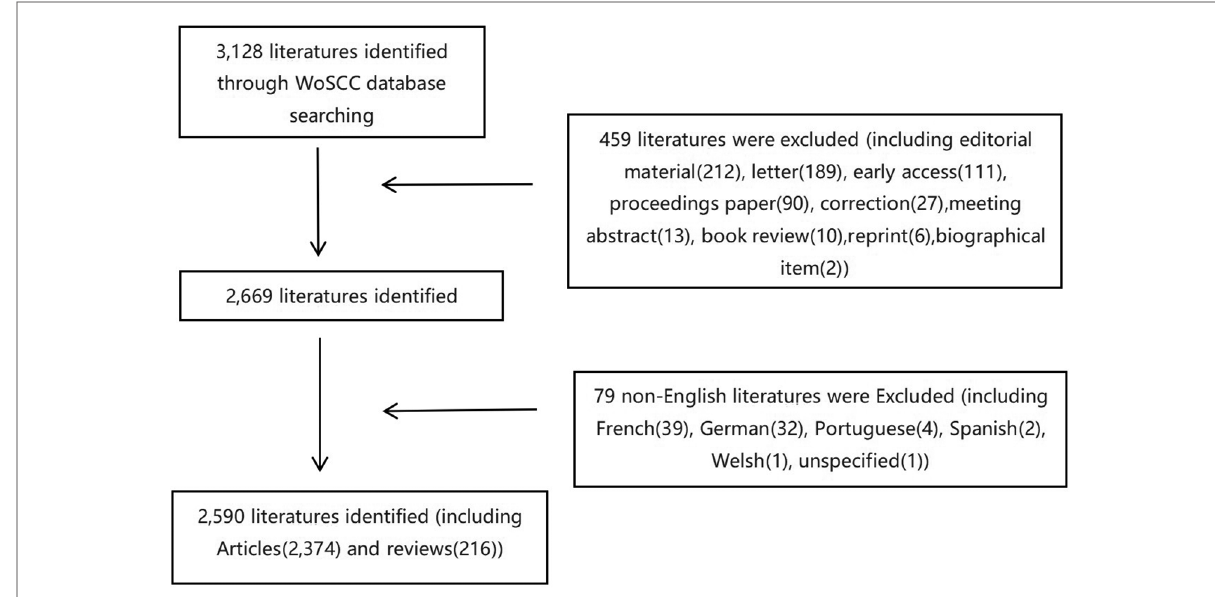
FIGURE 1 Flow chart of literature fi ltering in this study. WoSCC, Web of Science Core Collection.